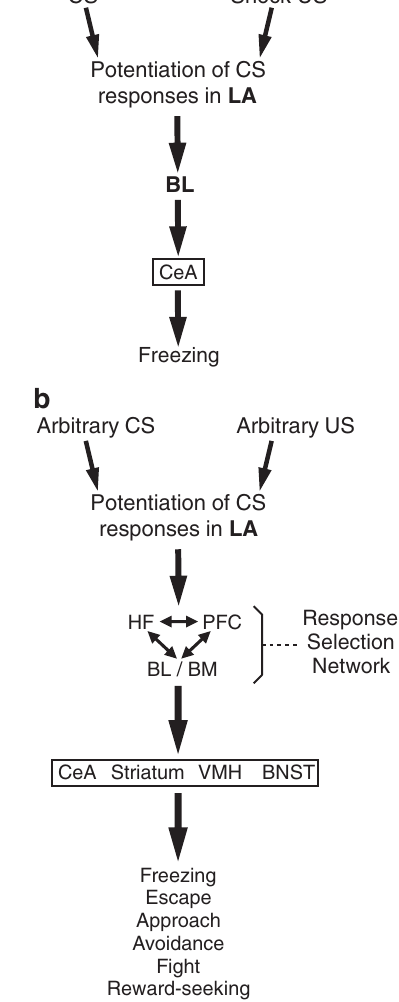
Fig. 3 Schema of connections through the amygdala. a View based on fear conditioning. Convergence of tone CS and shock US potentiates tone responses of neurons in the LA, which then activate BL amygdala neurons to drive freezing via the CeA.